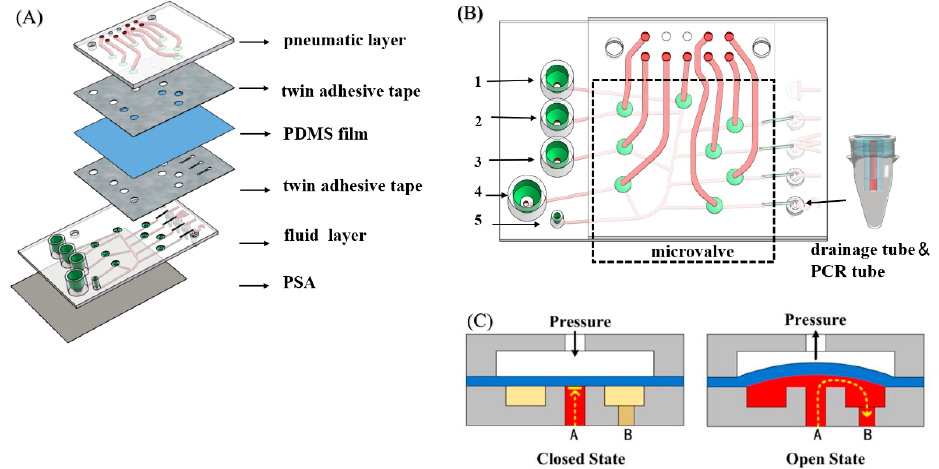
Figure 1. ( A ) Exploded diagram of the device. ( B ) Schematic illustration of the device. One to three are reagent reservoirs, 4 is a vent and 5 is a Luer taper connected to a syringe pump. Polypropylene PCR tubes can be fitted with the connectors on the device. ( C ) Cross section of a microvalve and its working principle.